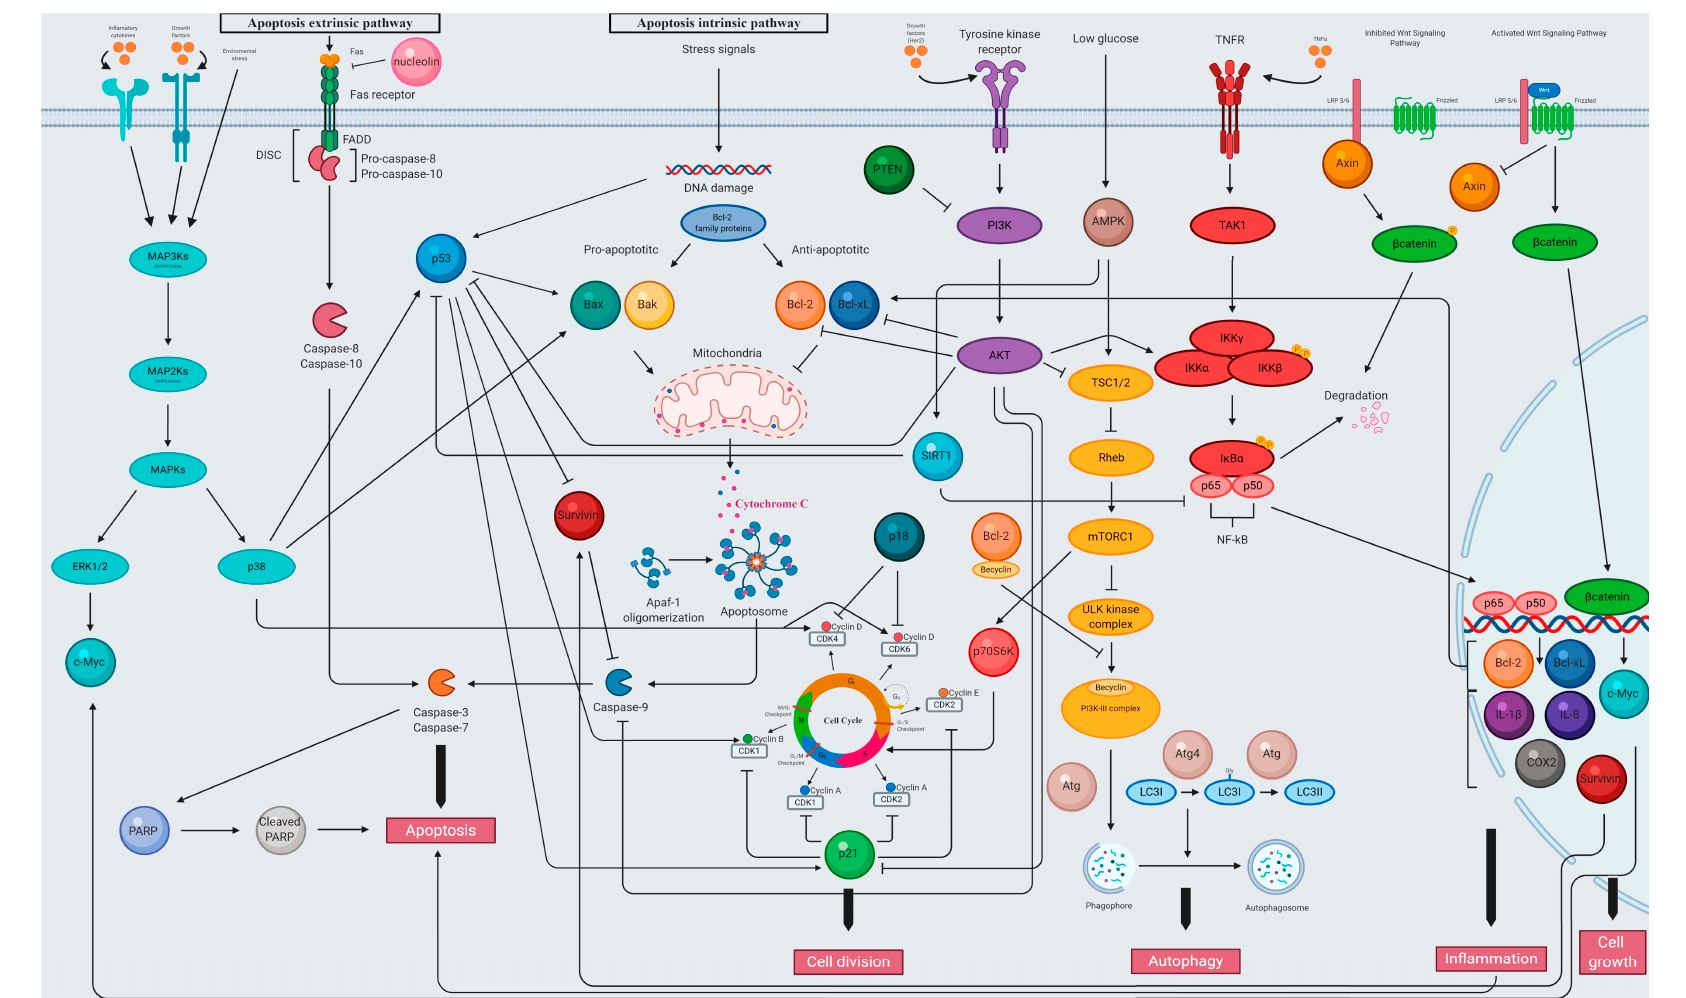
Figure 2. Selected molecular mechanisms of action of extracts, single derived compounds and essential oils from the Lamiaceae family against lung, breast, prostate, and colon cancer cell lines (created by BioRender). Abbreviations: Akt—protein kinase B, AMP—adenosine monophosphate, AMPK—AMP-activated protein